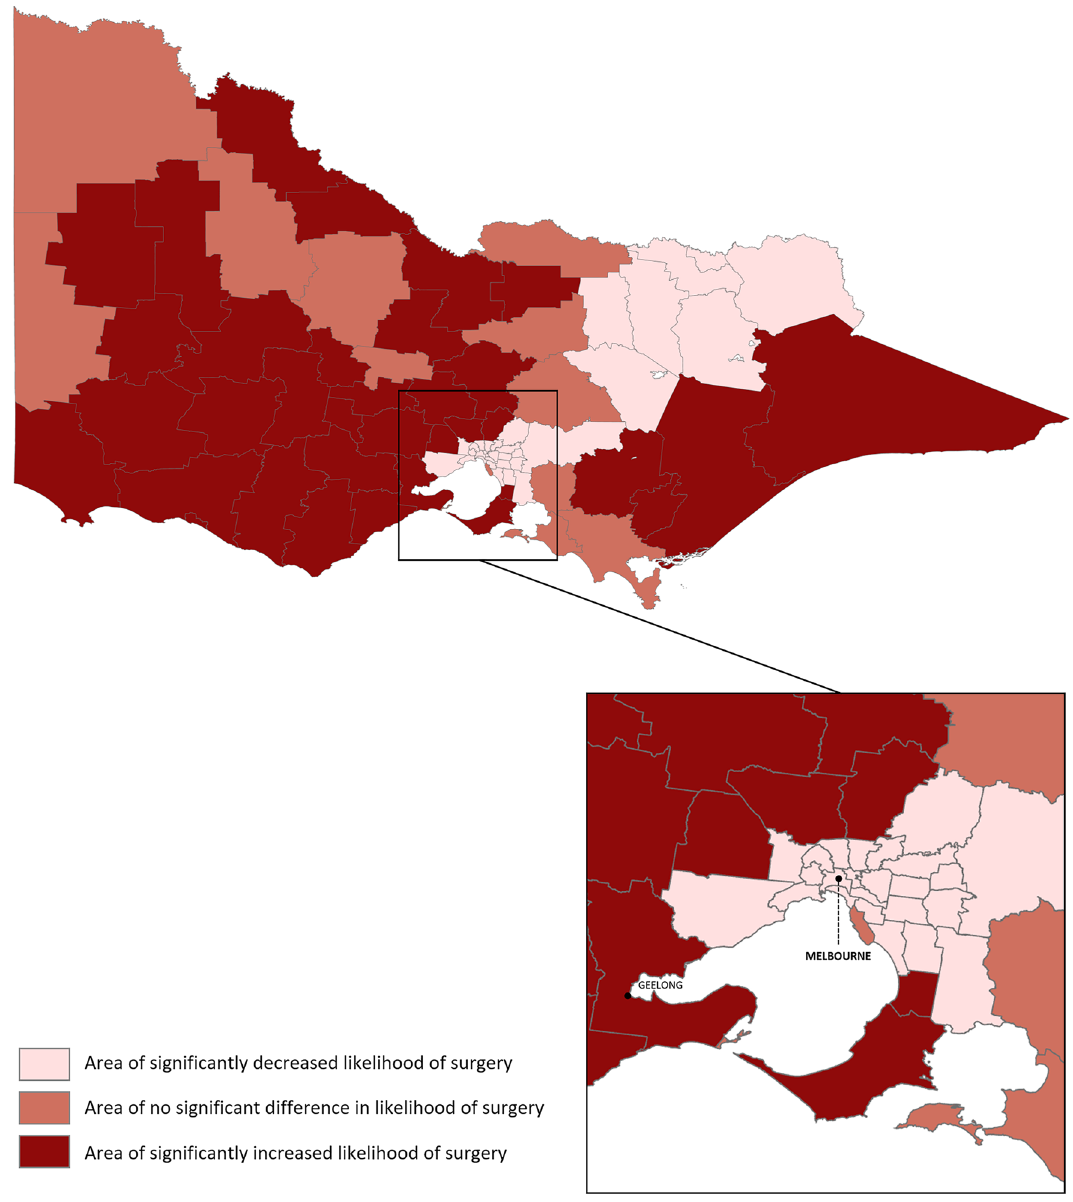
Figure 1. Standardised incidence ratio (SIR) of paediatric tonsillectomy, adenoidectomy and adenotonsillectomy, age standardised, by Local Government Area (LGA) in Victoria, Australia, 2010–2015. The inset map shows the city of Melbourne. Maps were generated in ArcGIS Pro (version 2.3.0, Esri Inc.) 18